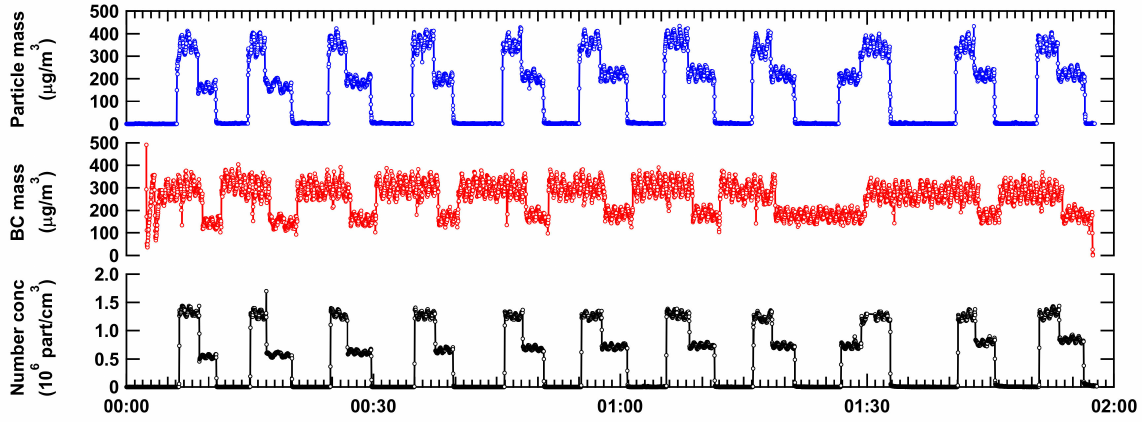
Figure 2. Example of the particle number concentration, black carbon (BC), and particulate matter (PM) mass time series from a typical